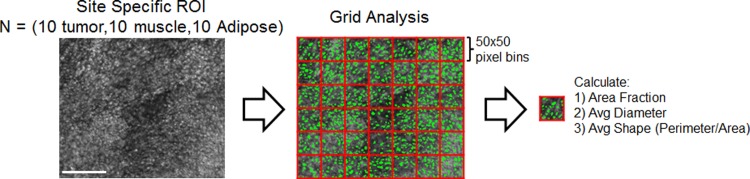
Site-level analysis.Flow chart which demonstrates the quantitative analysis carried out on the site specific ROIs. The purpose of this analysis was to develop a predictive model to differentiate tumor tissue from muscle and adipose. A total of 30 images were used as a training dataset to develop the model. Each image was further divided into smaller bins to ensure very localized disease could be detected. Finally, area fraction, average diameter, and average shape were calculated for each bin and used as input variables for a logistic regression model. Scale bar is 200 μm.